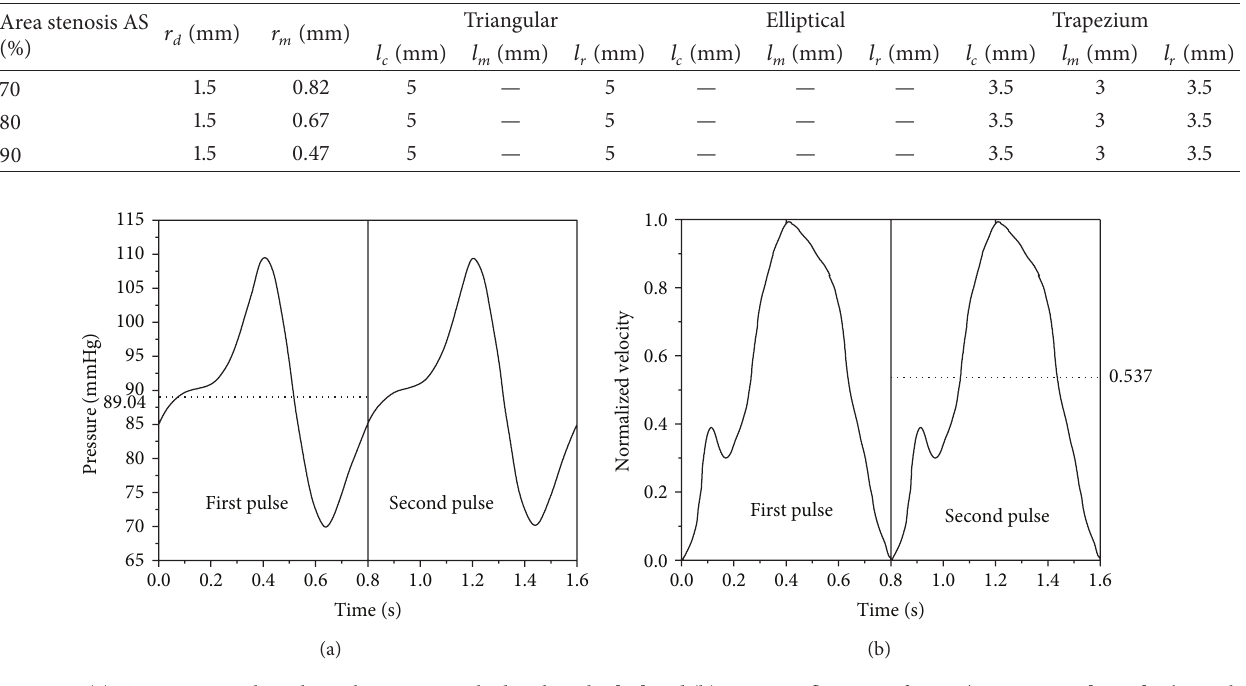
Figure 2: (a) Time varying physiological pressure applied at the inlet [14] and (b) coronary flow wave form 𝑢/𝑢 𝑝−𝑡 versus 𝑡 [10, 16]. The peak velocity 𝑢 𝑝−𝑡 corresponds to a normalized velocity of 1.0 so that the ratio of mean to peak velocity 𝑢/𝑢 𝑝−𝑡 is